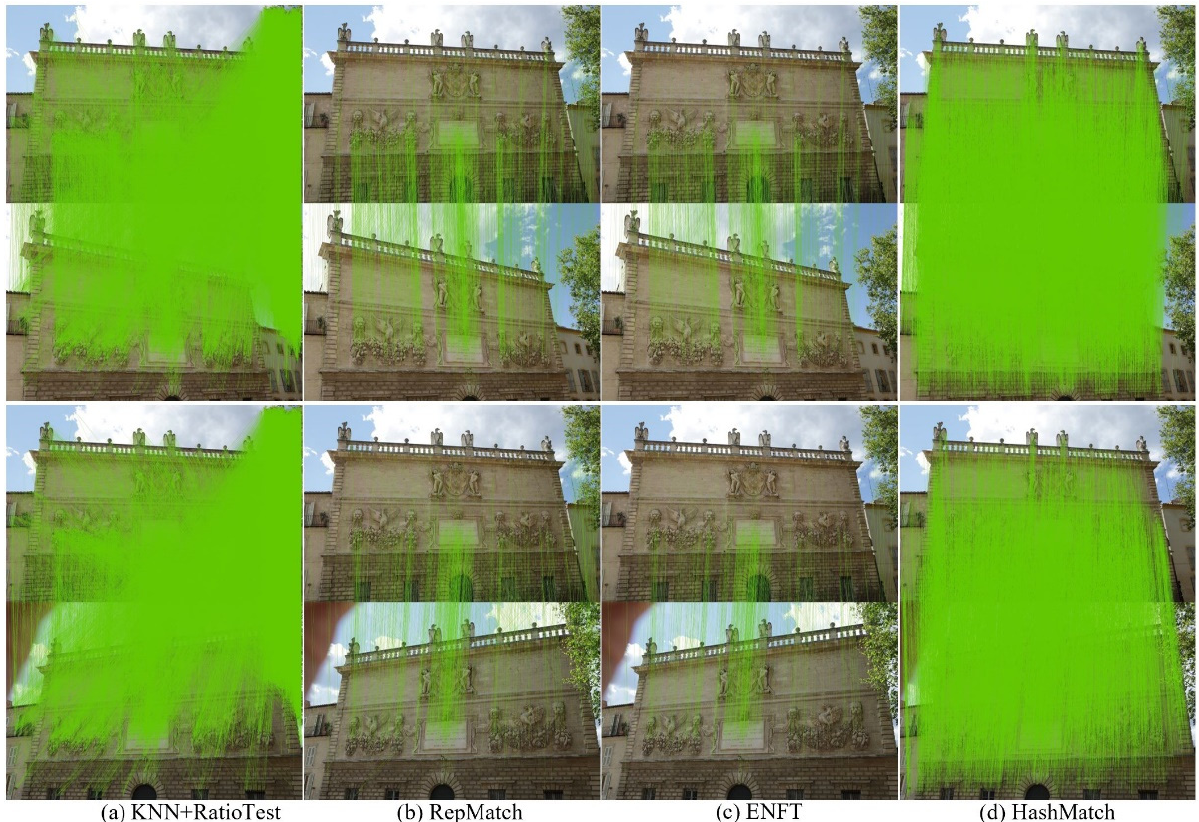
Figure 11. Feature correspondences of the Hotel sequence. The HashMatch has the most correct feature correspondences. This proves that the HashMatch has more robustness to repeated features than that of the others.